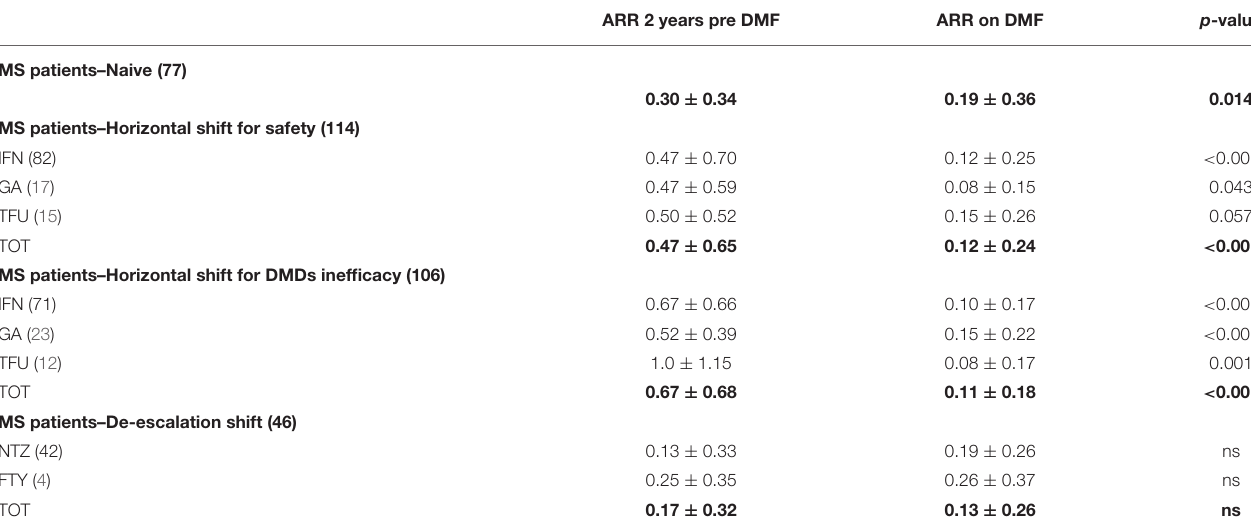
p = 0.041), also indicating an effect related to the DMF